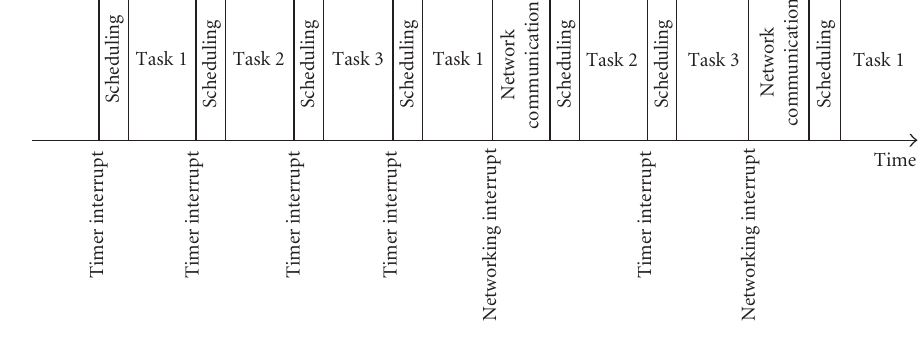
Figure 8: Scheduling diagram. Table 1: Timeline of the migration mechanism.